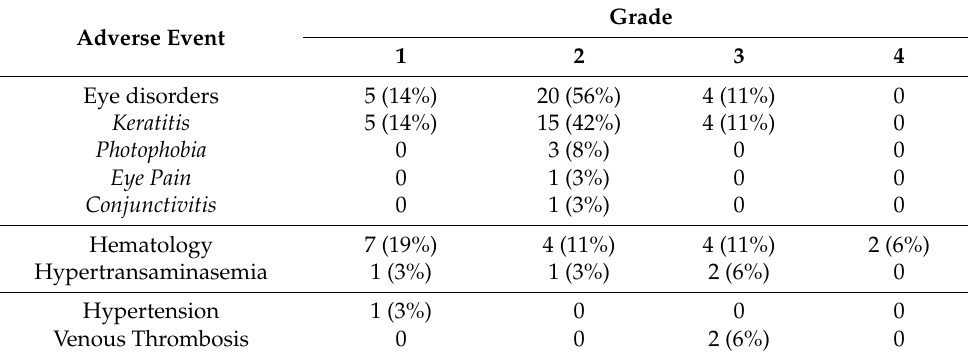
Table 6. Drug-related treatment-emergent adverse